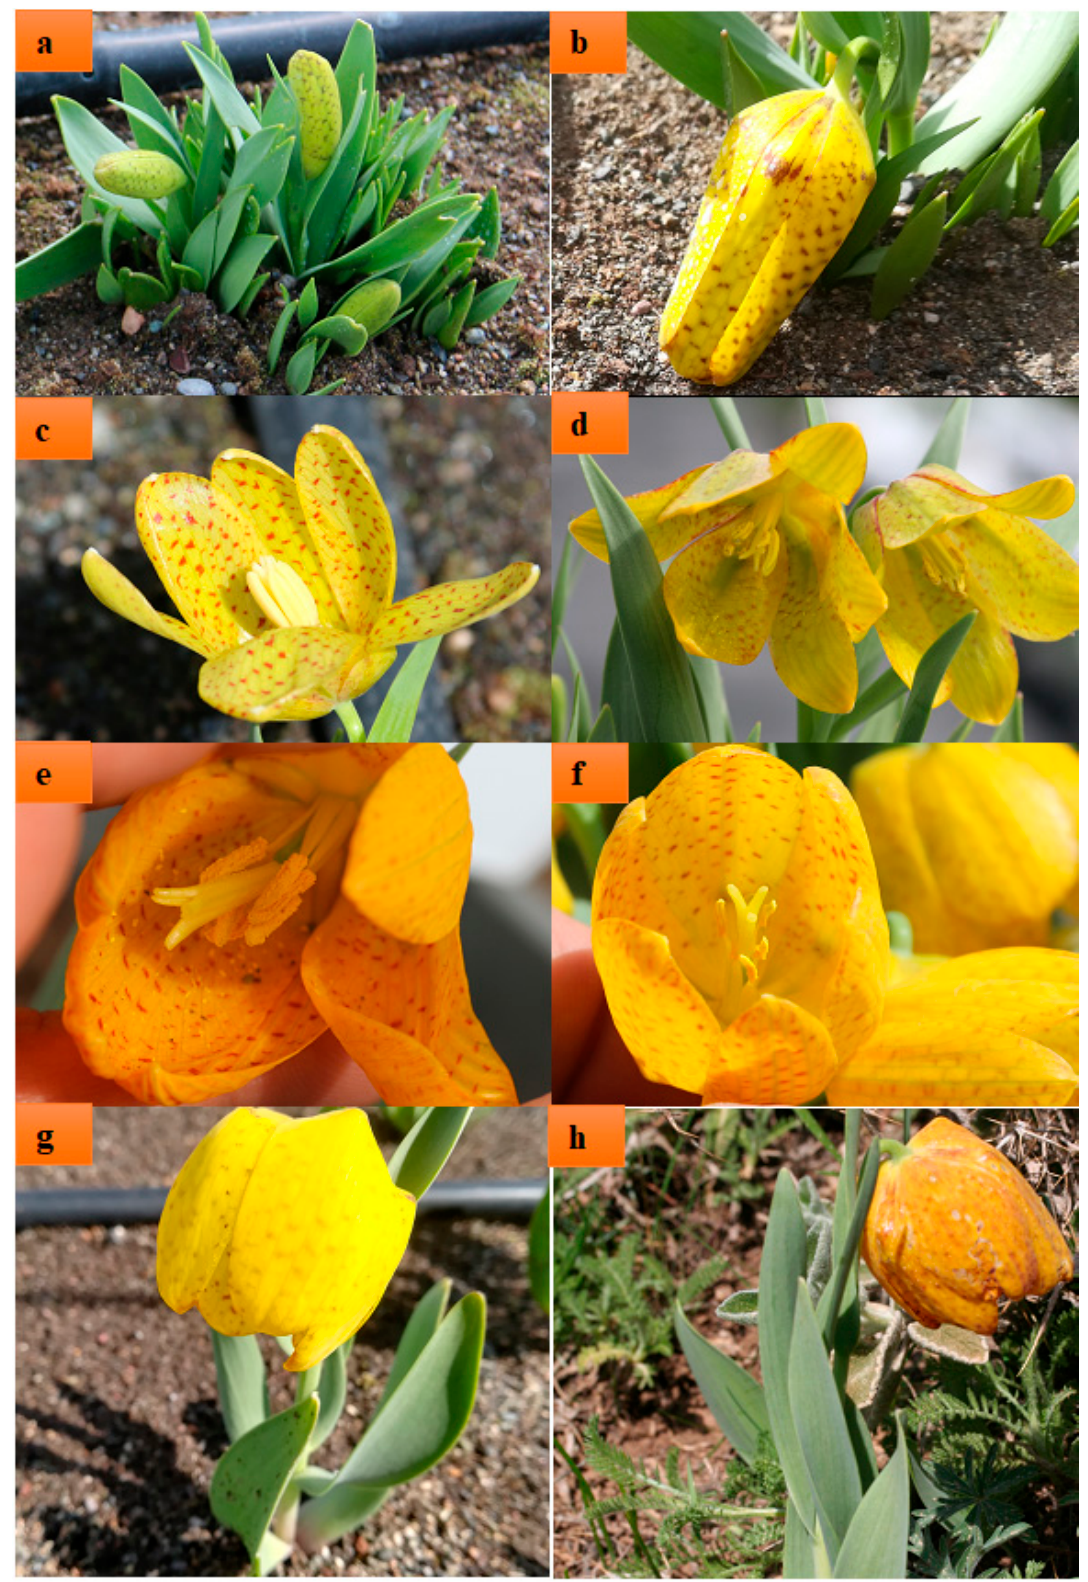
Figure 3. The blossom process of Fritillaria aurea : ( a ) bud stage, ( b ) initial flowering, ( c ) pre-dehiscence stage, ( d ) first dehiscence stage, ( e ) full dehiscence, ( f ) end-dehiscence stage, ( g ) fresh perianth stage, and ( h ) perianth wilting stage (original photo by M. Aslay).